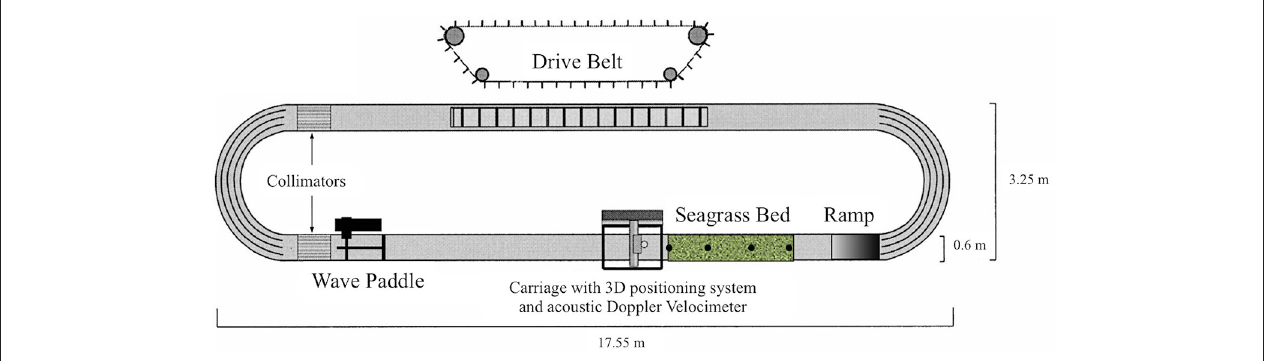
FIGURE 1 | Schematic diagram of the flume and seagrass bed (adapted from Paul et al., 2012). Filled circles in the seagrass bed represent the pots, which were inserted with three seagrass shoots in it, each pot representing a plant sample. These pots were placed at distances 0, 0.45, 0.9, and 1.35m from the leading bed edge along the central axis of the